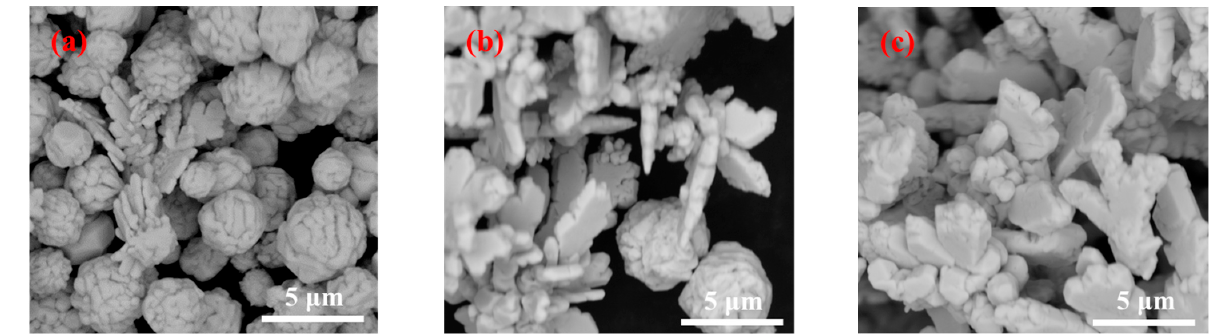
Figure 5. SEM images of the silver powder prepared under different flow rates by adding 1% gelatin. ( a ) 50 mL/min; ( b ) 75 mL/min; and ( c ) 100 mL/min.